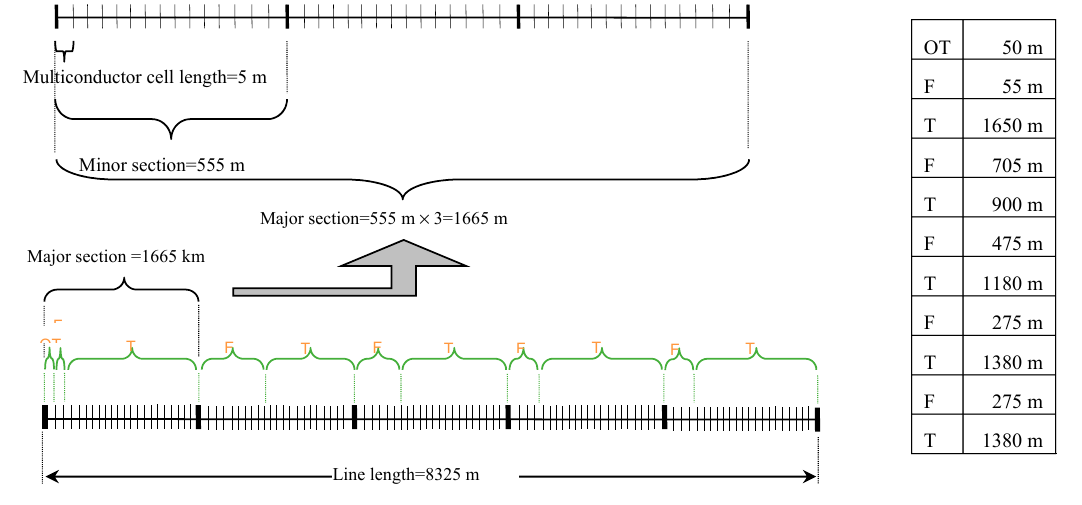
Figure 5. Subdivision of case #1 in elementary cells, minor and major sections. OT—open trefoil with spacing = 0.15 m; F—flat laying with spacing = 1 m; T—close trefoil.